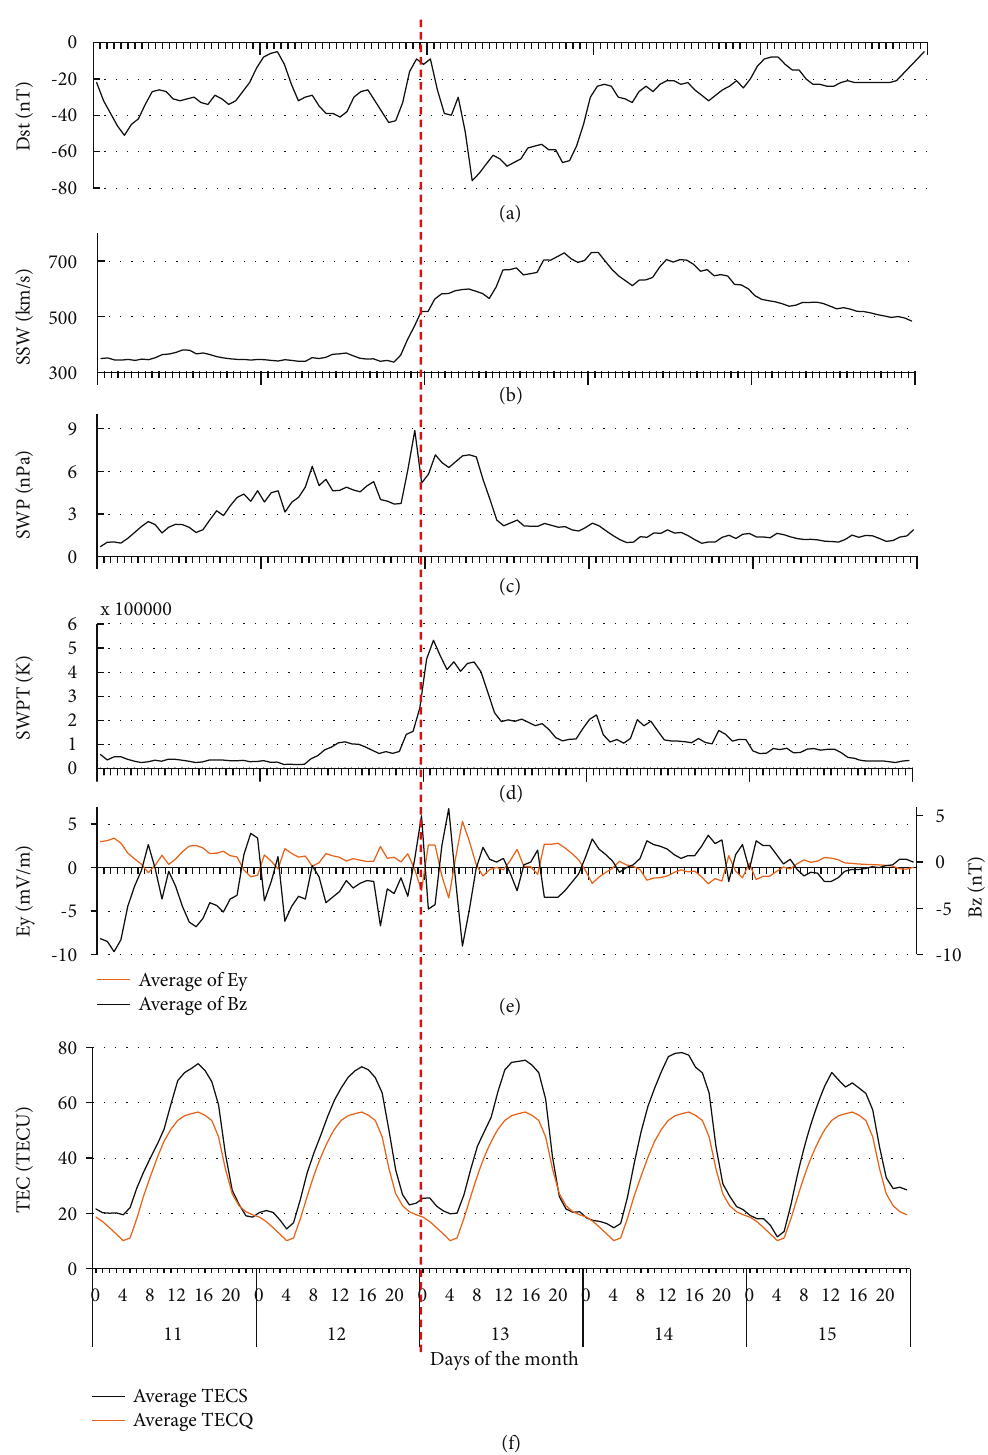
Figure 2: Variation of solar wind parameters and total electron content (TEC) from May 11 to 15, 2015, at the Koudougou GPS